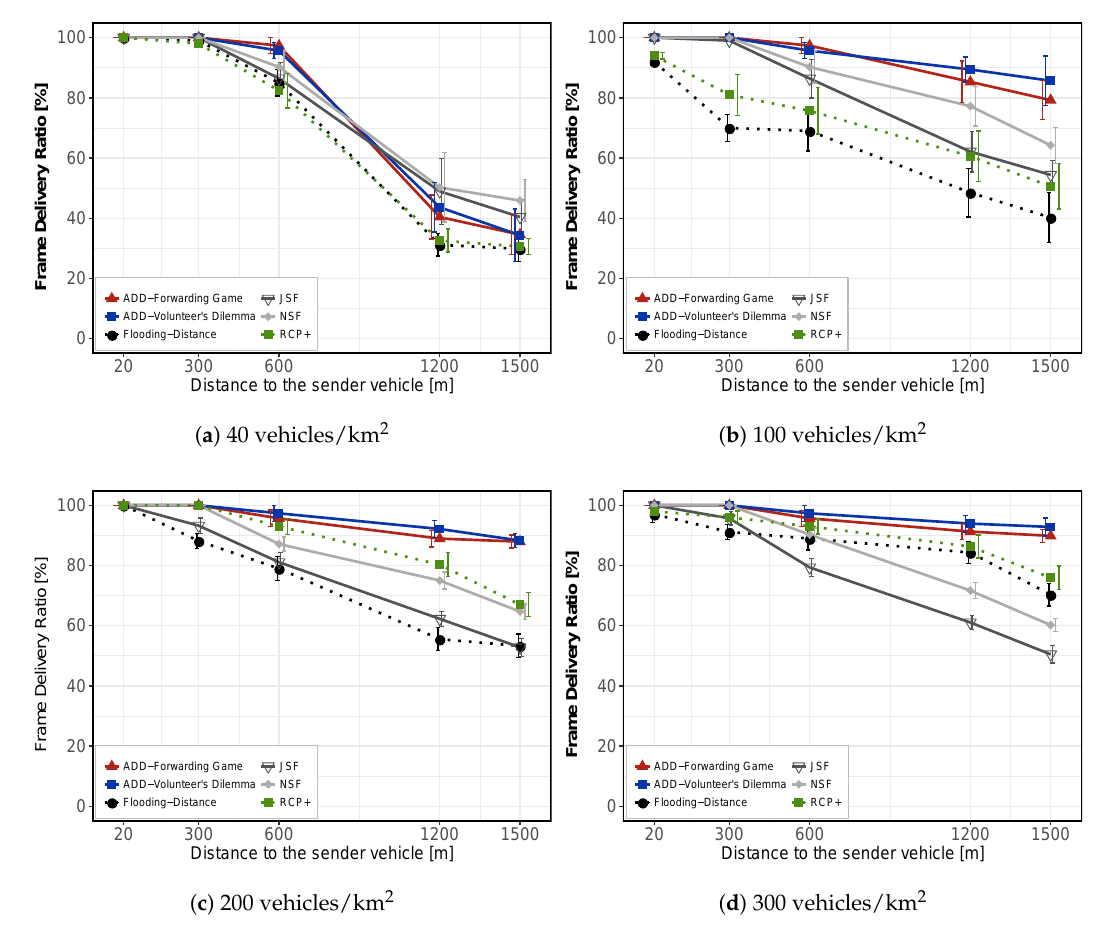
Figure 6. Frame Delivery Ratio (FDR) with 95% confidence intervals for 10 repetitions per point with independent seeds. Video dissemination case. Different vehicles’ densities in a 2.5 km × 2.5 km urban region in Berlin,